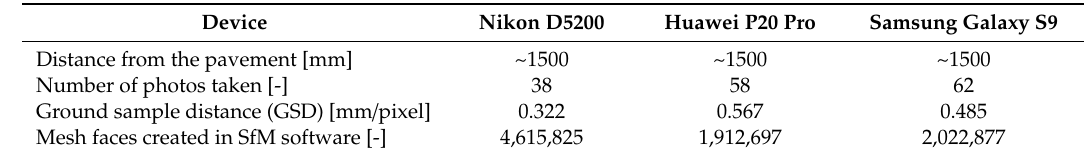
Table 3. Survey specifications for Distress 2.